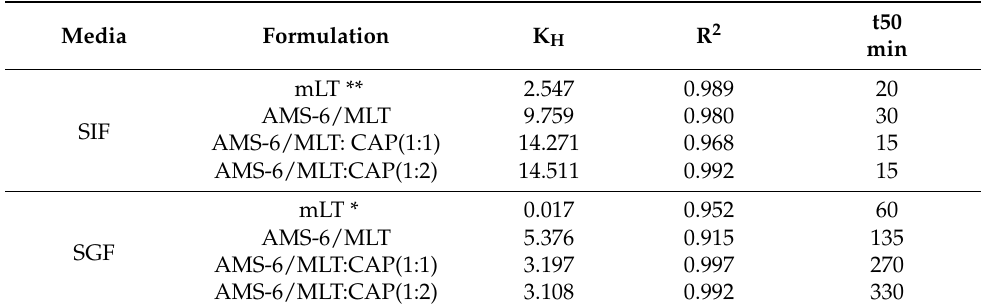
Table 1. Kinetic release constants for the AMS-6/MLT and AMS-6/MLT:CAP formulations for the kinetics was applied, assumed for mLT release in SGF and SIF,